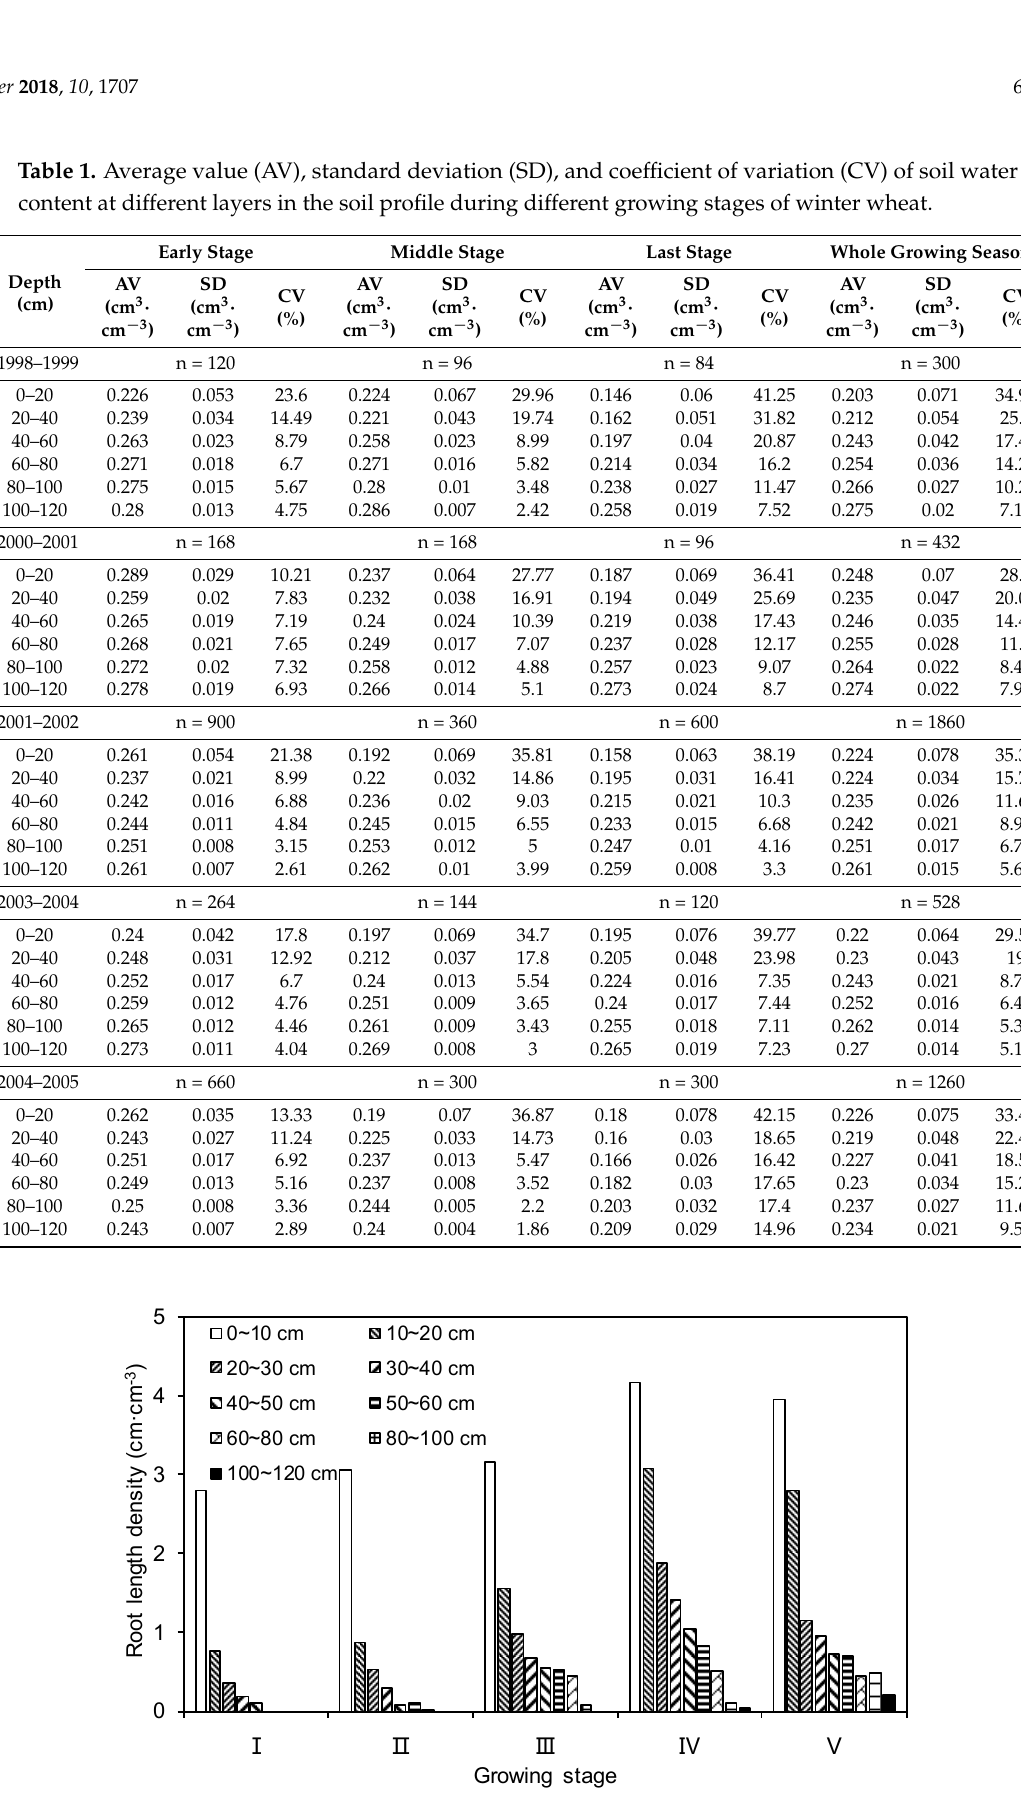
Figure 3. Density of winter wheat roots during different growth stages. Early: stage I; middle: stages II and III; last: stages IV and V.